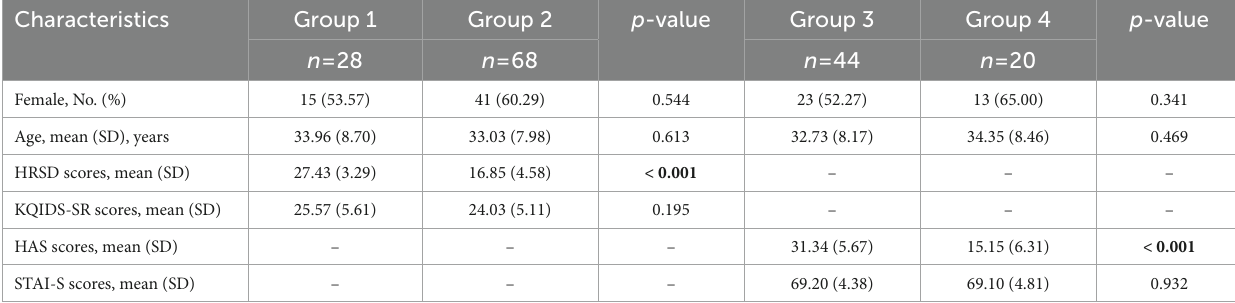
TABLE 1 Comparisons of demographic and clinical characteristics between groups 1 and 2, and between groups 3 and 4. Characteristics